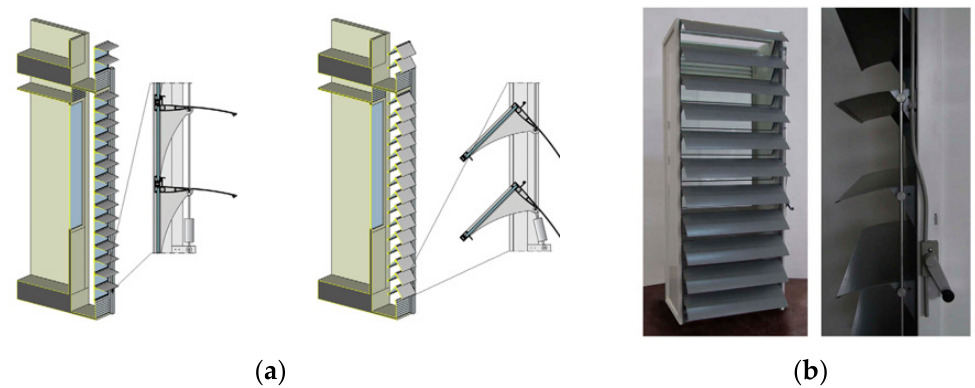
Figure 11. Movable shading devices: ( a ) model of the façade element in winter and summer; ( b ) experimental installation (data from ref. [96]) .